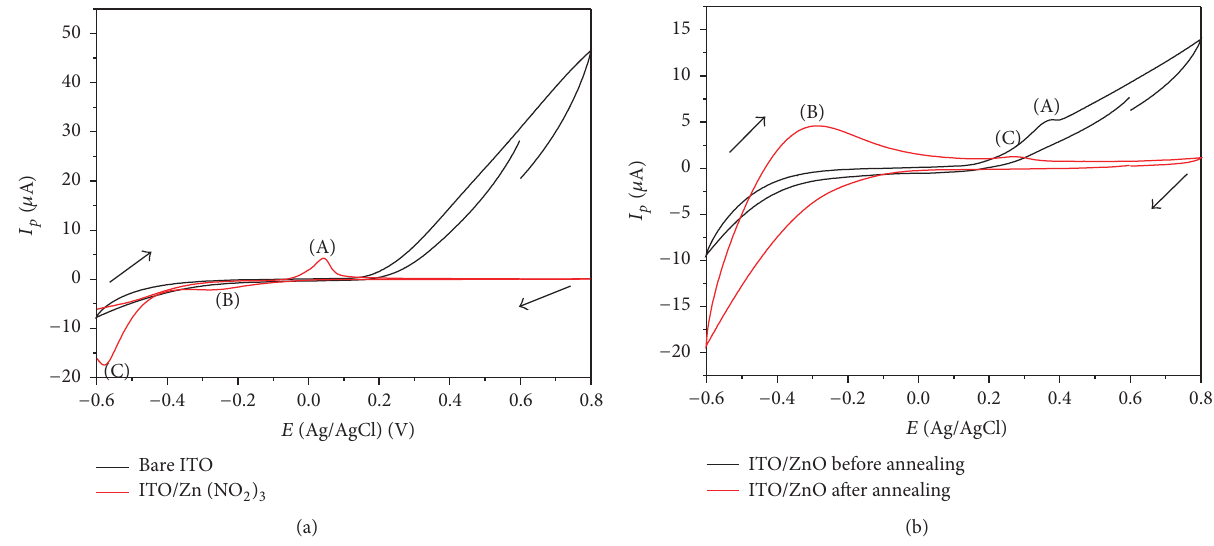
Figure 6: Cyclic voltammetric responses of electrode systems. (a) CVs of bare ITO and (b) ITO/ZnO before and after annealing. Experiments were carried out in 0.1M PBS (pH = 7) at 50 mVs −1